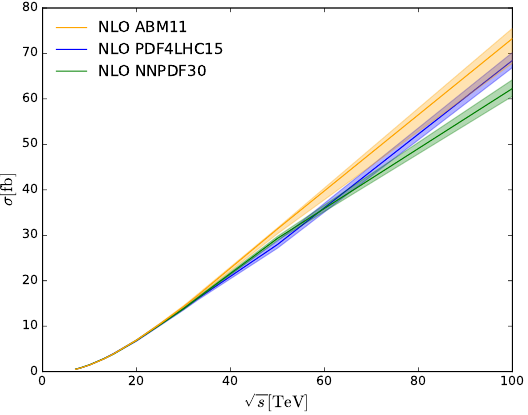
Figure 4 . Dependence of the total cross section on the center of mass energy using di(cid:11)erent PDF sets. The bands show the PDF and scale uncertainties added in quadrature.